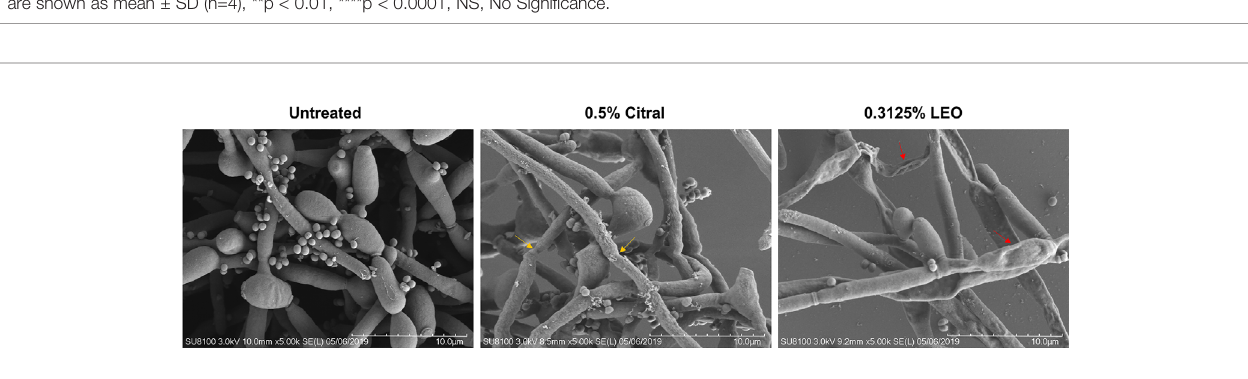
Frontiers in Cellular and Infection Microbiology |